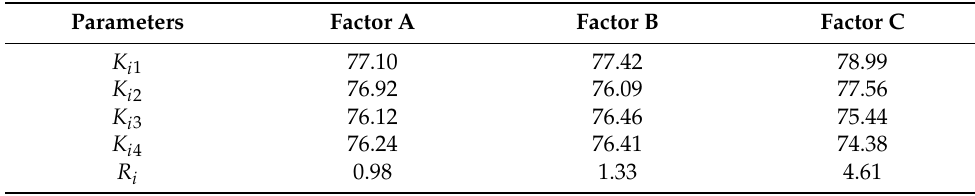
Table 7. Range analysis results for liquid mass fraction.